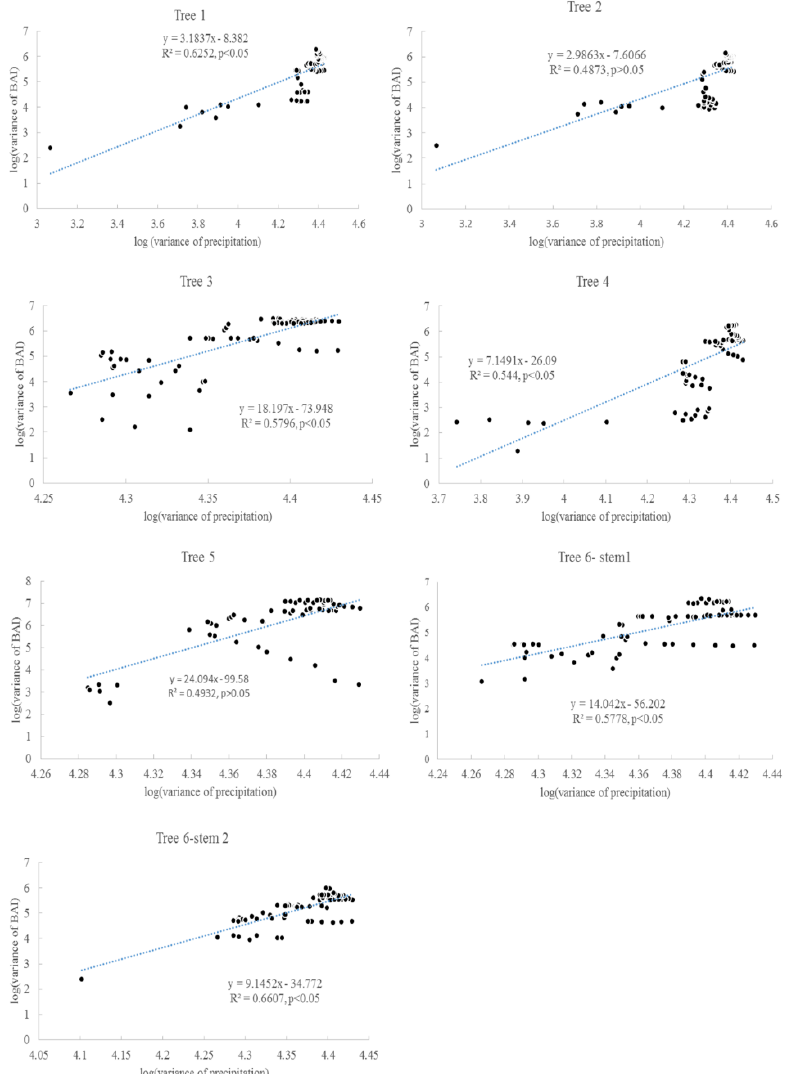
Figure 11. Correlation between BAI variances and the variances of precipitation in the growing seasons for six Chinese Torreya trees.